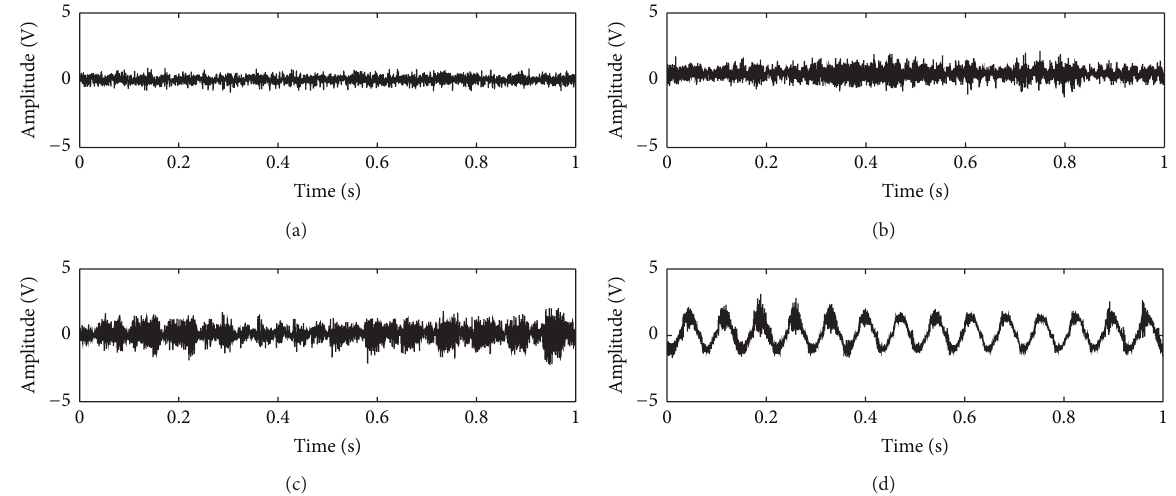
Figure 2: Vibrations of screw fixed end under different service life: (a) vibration of 0.5-year-service screw, (b) vibration of 2-year-service screw, (c) vibration of 5-year-service screw, and (d) vibration of 7-year-service